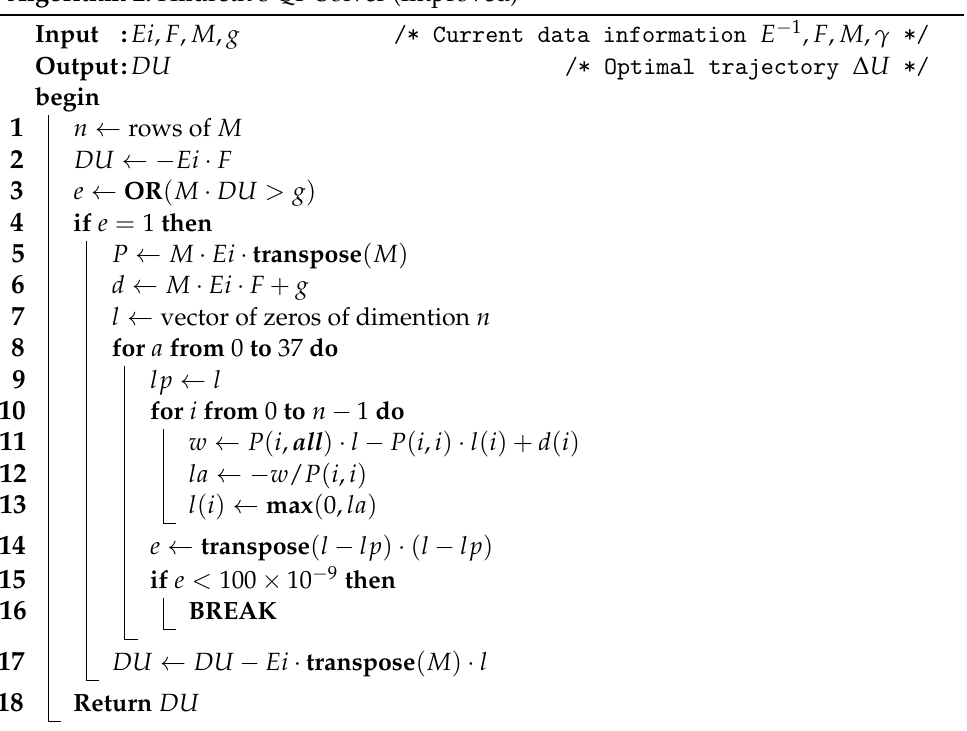
Algorithm 2: Hildreth’s QP Solver